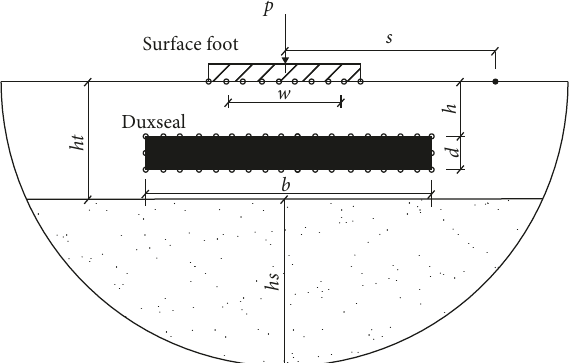
Figure 4: Schematic of Duxseal as a vibration isolation system in the layered elastic